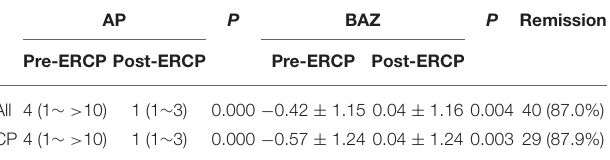
TABLE 4 | Long-term outcomes of 46 pediatric patients. AP P BAZ P Remission